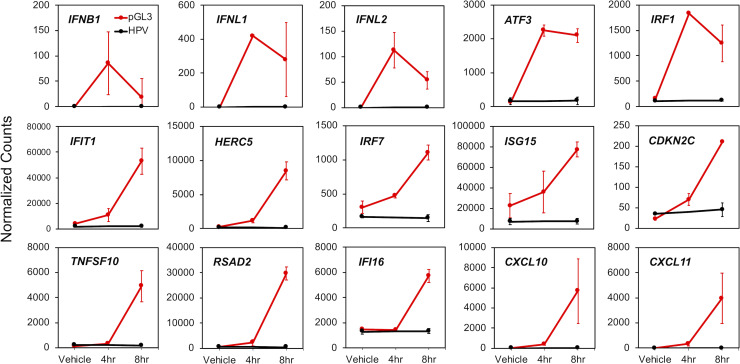
HPV-related DNA-responsive cellular genes are not induced by virion infection.Normalized RNA-seq count data were plotted for a subset of 15 DNA-responsive cellular genes selected based on prior literature indicating a relationship with HPV. Error bars represent 95% confidence intervals (n = 2 for pGL3 transfection, red, and n = 3 for HPV virion infection, black).